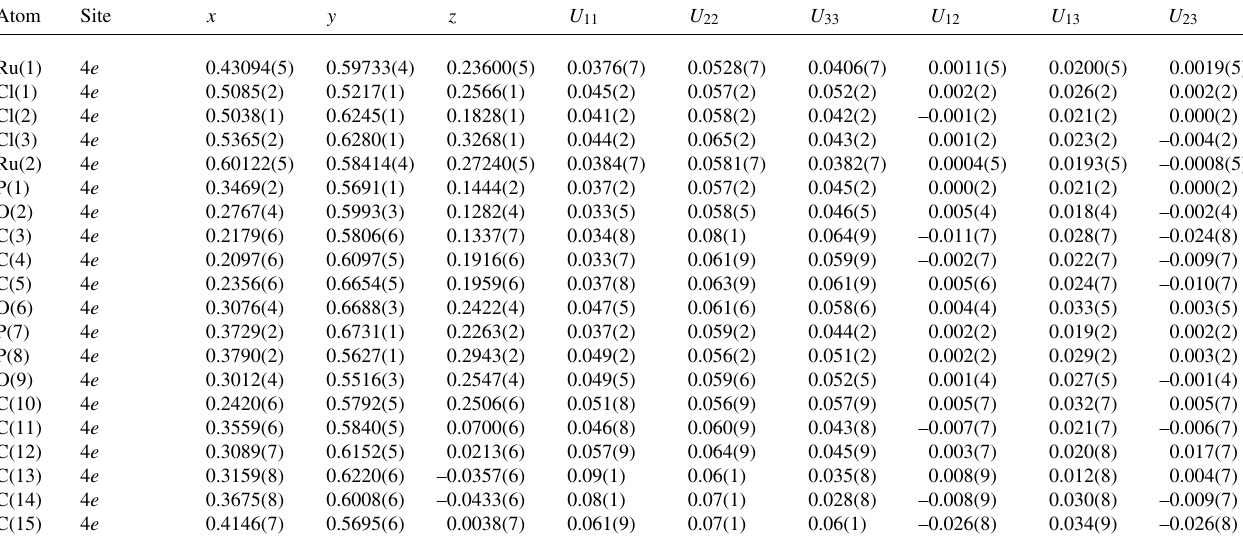
Table 3. Atomic coordinates and displacement parameters (in Å 2 ) .